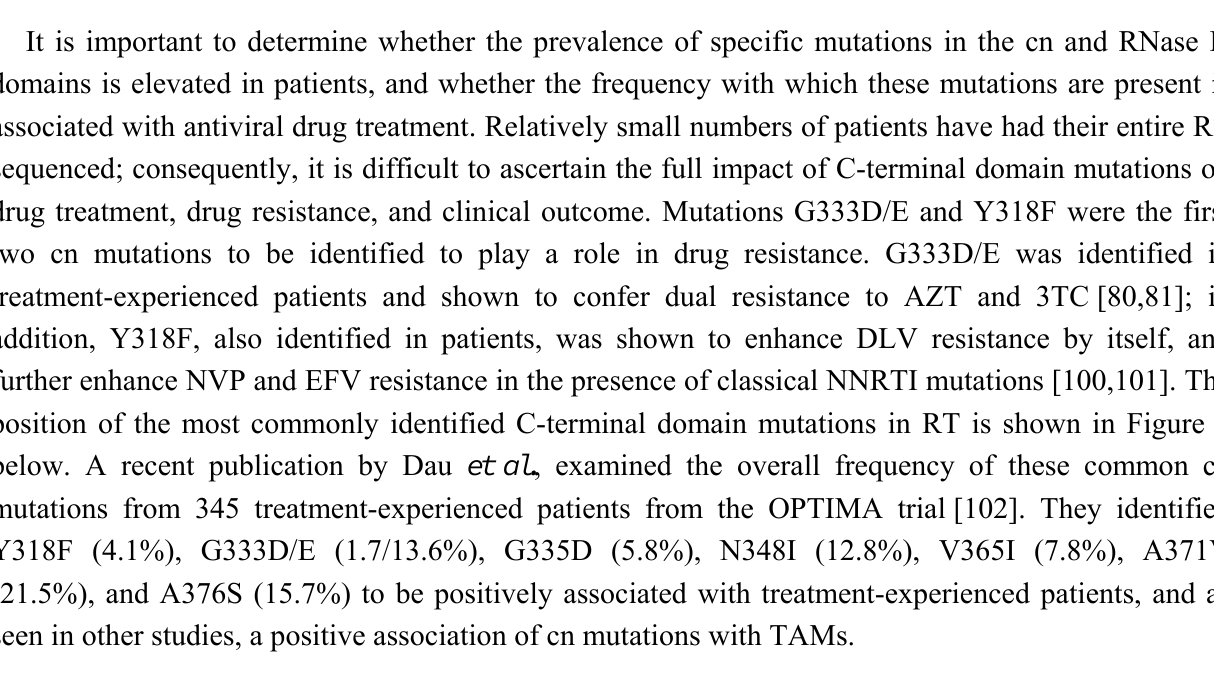
Figure 6. Location of C-terminal domain mutations in p66 (A) and p51 (B) involved in RTI resistance. Coloring code: red, connection subdomain; green, RNase H domain; purple, fingers and palm and thumb domain; RNA, thin gray line; DNA, thick gray